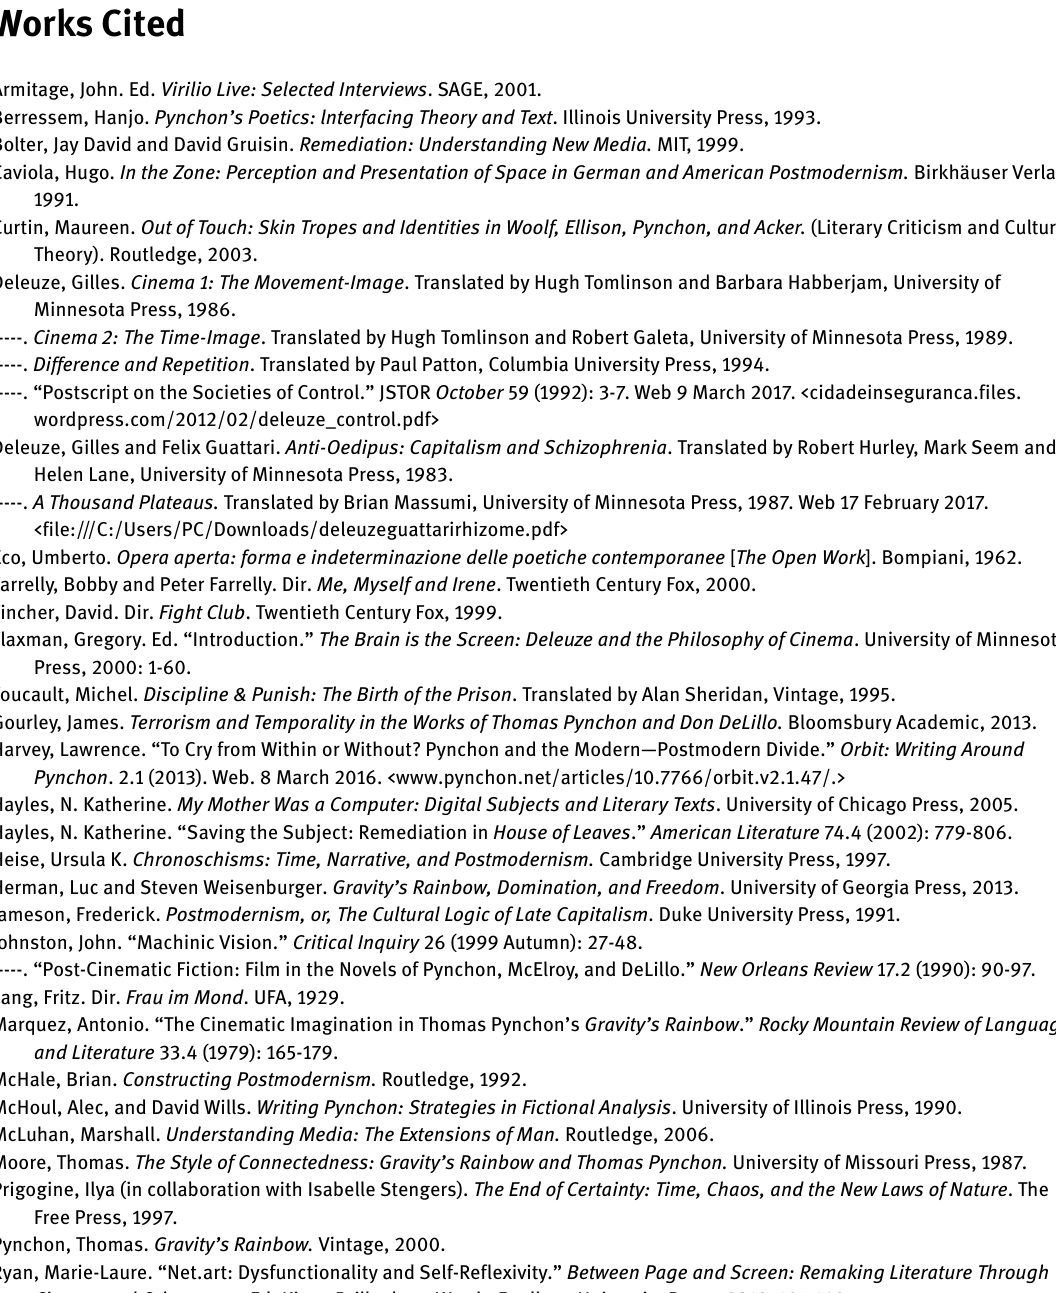
(as are Pynchon’s characters) to the point of indiscernibility. The movement-image gave way to the time- image, which is direct and simultaneous, “plunged into time rather than crossing space,” deterritorialized, where “the sheets of past coexist in a non-chronological order” (Deleuze, Cinema 2 xii), as events unfold in Gravity’s Rainbow, gravid with cinematic concepts. The film-saturated space-time that emerges, along with speed and acceleration, offers a growing awareness of living a multiplicity of times and of moving at different speeds (as Pökler and Slothrop experience), projecting the realm where the real and the virtual are